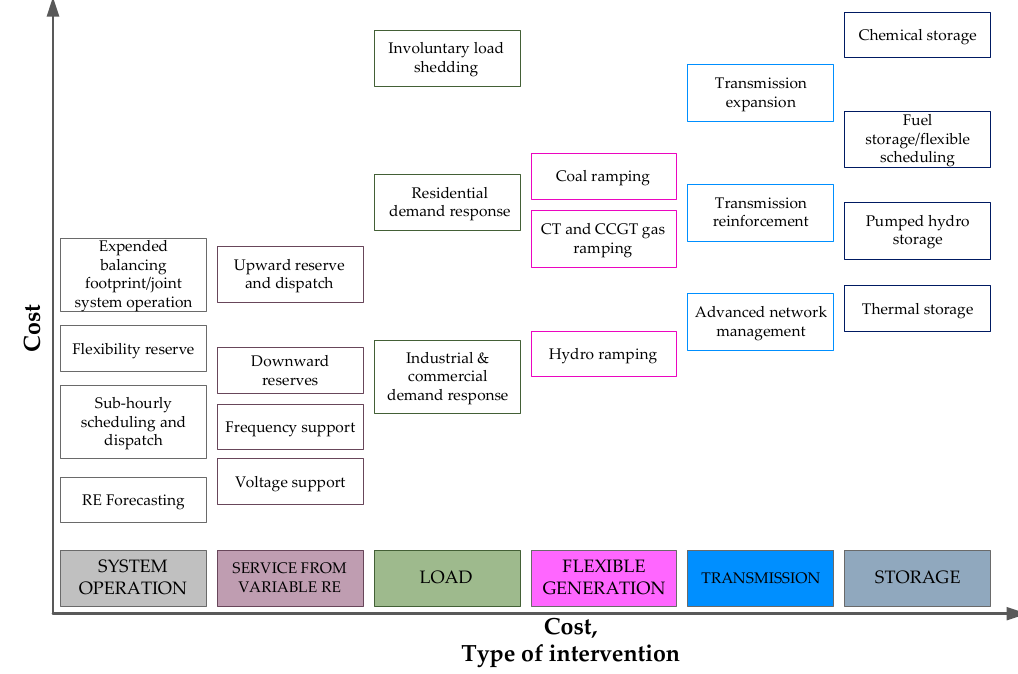
Figure 3. The classification of interventions to increase flexibility [31]. RE: renewable generations.